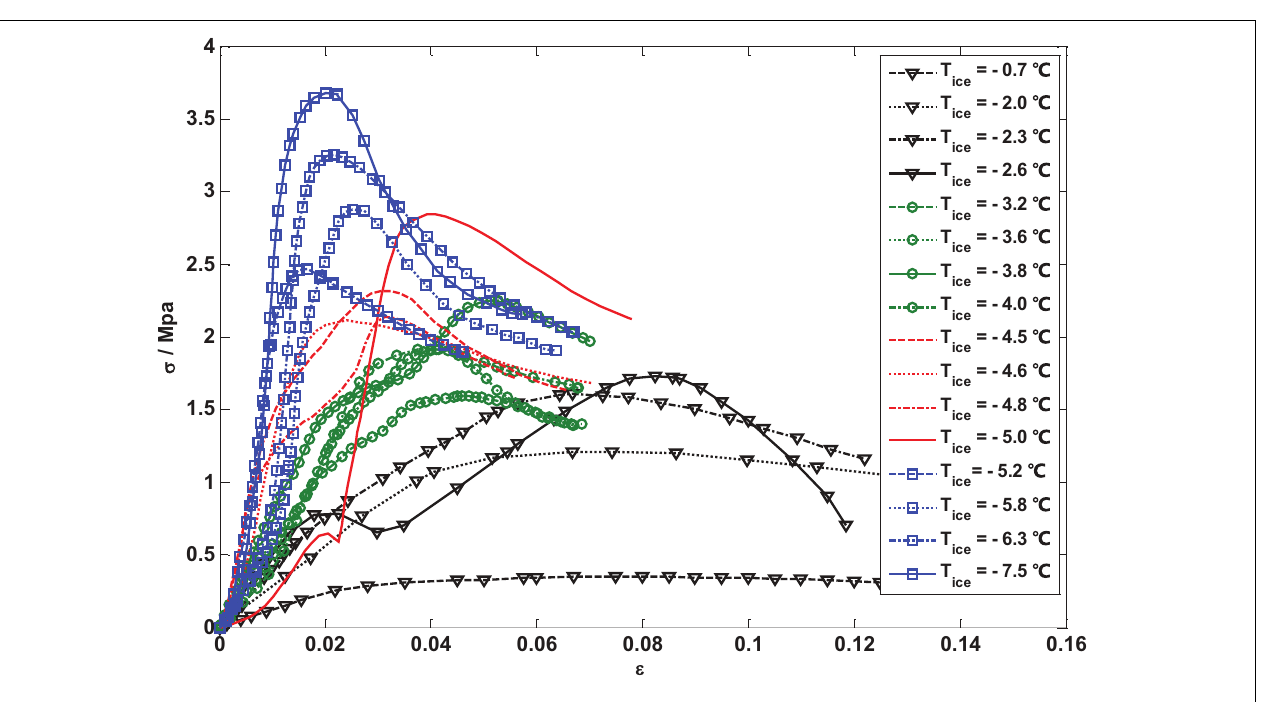
The test results are aggregated in Table 1 . It can be seen from Figure 6 that the obvious peak value of stress can be observed in the sub-figures. Typically, the stress grows up with the strain increase and then falls down after the stress reaches its